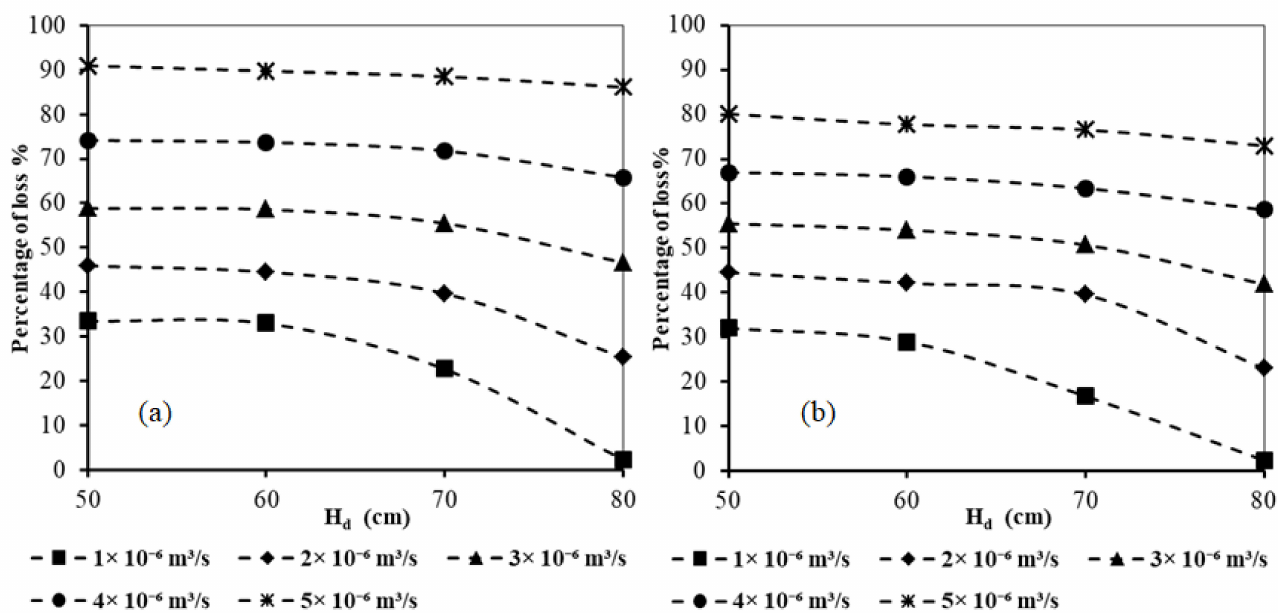
Figure 11. Relation between subsurface dam height and loss of subsurface dam effectiveness for L d = 0.50, D F = 0.005 m, H f = 0.1 m, and L w /L d = 2.0 for: ( a ) and H w /H d = 0.25, and ( b ) H w /H d =